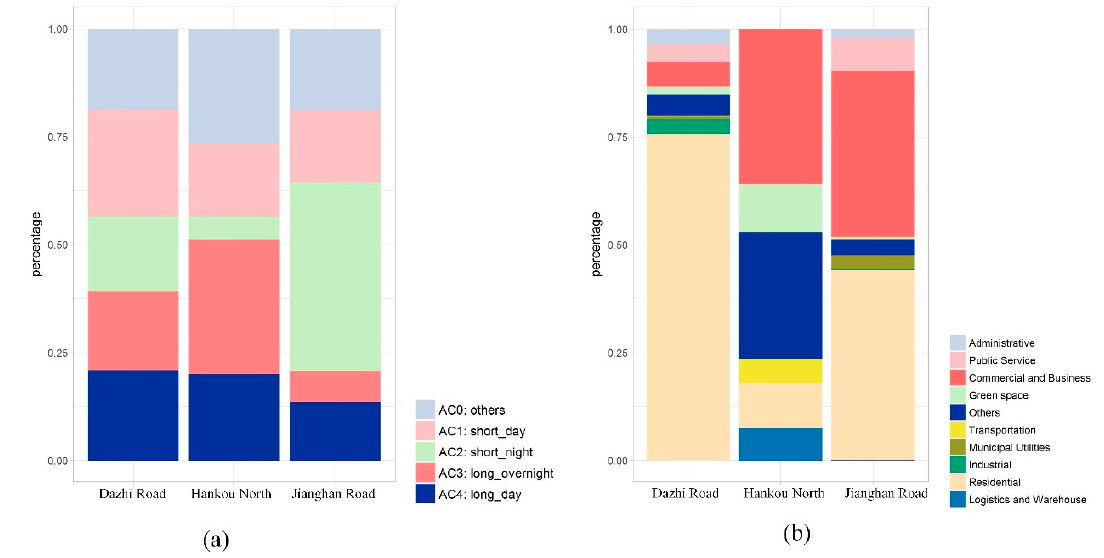
Figure 8. Illustration of three examples: ( a ) the staying activities distribution; ( b ) the land use distribution. Sometimes, although two stations show similar land usage, the functions are